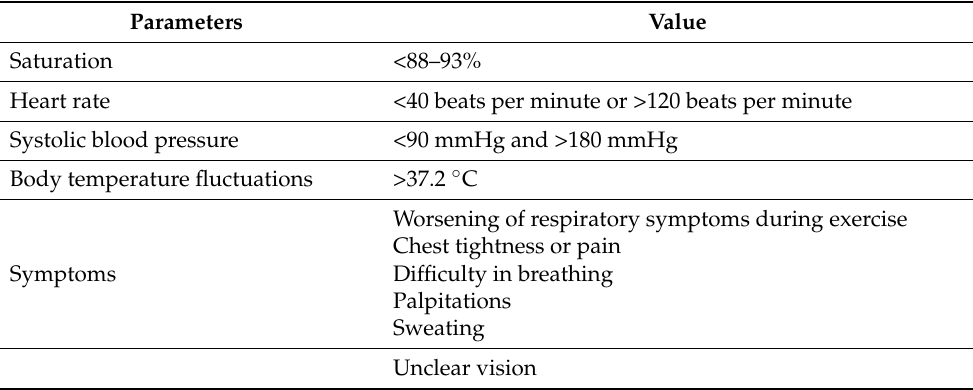
Table 2. Adverse hemodynamic events during cardiac rehabilitation, especially after COVID-19 (adapted after